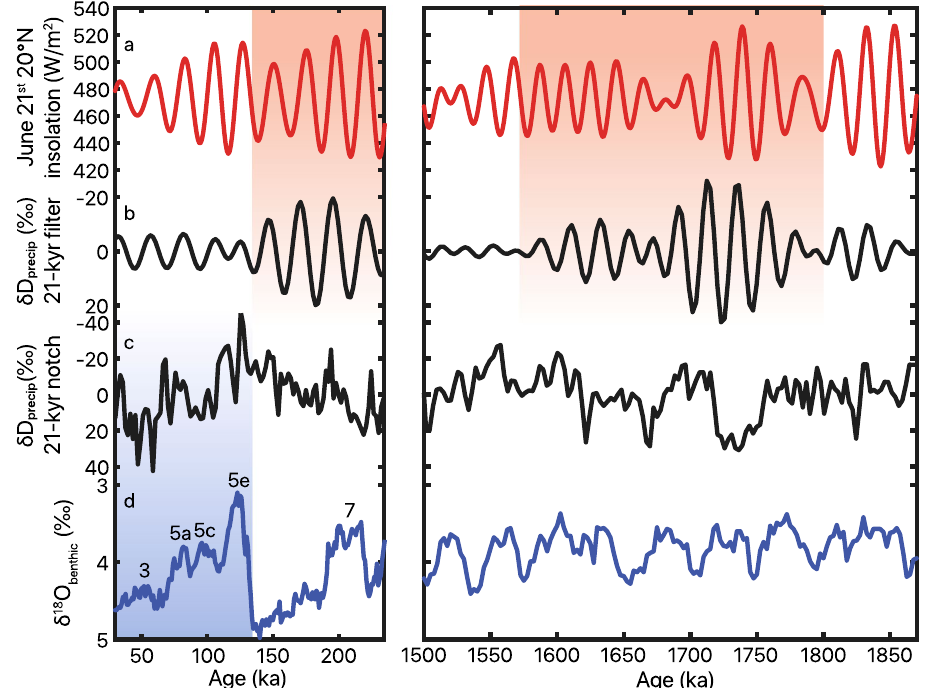
Figure 4. Gaussian 21-kyr ± 5-kyr band-pass ( b ) and notch ( c ) filtering of the δD precip study intervals truncated to 1870–1500 ka and 250–30 ka to omit low sampling resolution sections. June 21st zonal mean 20° N insolation 65 ( a ) plotted and highlighted in light red demonstrate similarity with high- and low-amplitude variability packets in gaussian band-pass filtered δD precip . Our selection of June 21st insolation at 20°N is based on observations from latest Pleistocene and Holocene records demonstrating the sensitivity of eastern African precipitation to this date and latitude 14,61,84,88 . We note that the chronologies for the CHB14-2 and WTK13 records are too imprecise to determine the phase of the response of δD precip to orbital forcing; however, the choice of latitude and season does not influence our spectral analyses nor other results. Benthic foraminifera δ 18 O stack 32 ( d ) plotted with recent interglacial MIS’s and highlighted in light blue to demonstrate similarily with late Pleistocene notch-filtered (precession-band periodicities removed) δD precip . Means were removed in both band-pass- and notch-filtered data to feature changes in